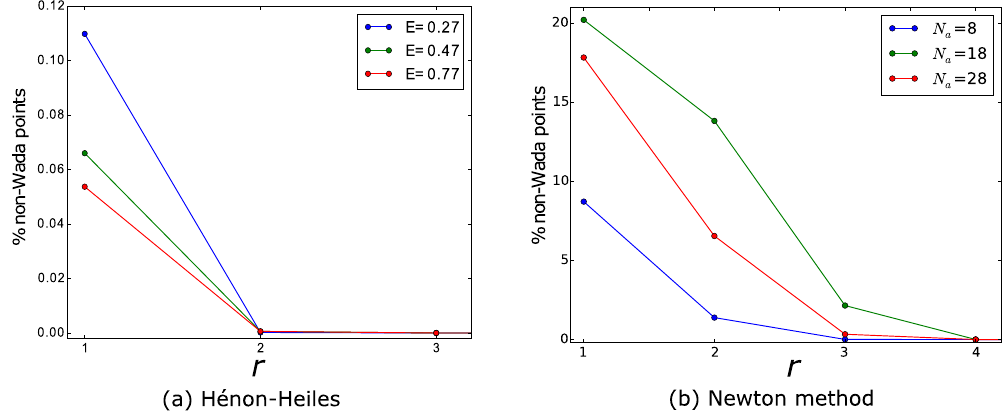
Figure 4. The role of the fattening parameter r . ( a ) The number of non-Wada points decreases as the fattening parameter r increases for all the values of the energy studied in the Hénon-Heiles Hamiltonian. Only three values of the energy are plotted for clarity, but we have checked that there is no relation between the percentage of non-Wada points and the value of the energy E , i.e., there is no relation between the percentage of non-Wada points and the fractal dimension of the boundary. ( b ) The merging method converges for values of the fattening parameter r ≤ 4 in the Newton method to find complex roots. There is no direct relation between the number of attractors and the percentage of non-Wada points. For both systems and all the parameters tested, the merging algorithm correctly classifies the basins as Wada basins for every r >